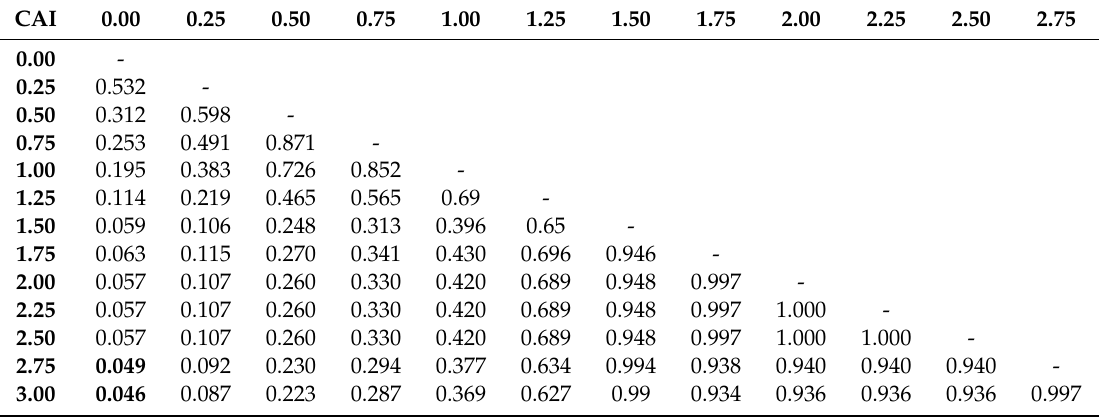
Table A2. p -value of Levene’s test of homogeneity of variances between training sets of various CAI thresholds. Null hypothesis: the population variances are equal. In bold: training set combinations that reject the null hypothesis at α = 0.05 and whose variances are therefore not